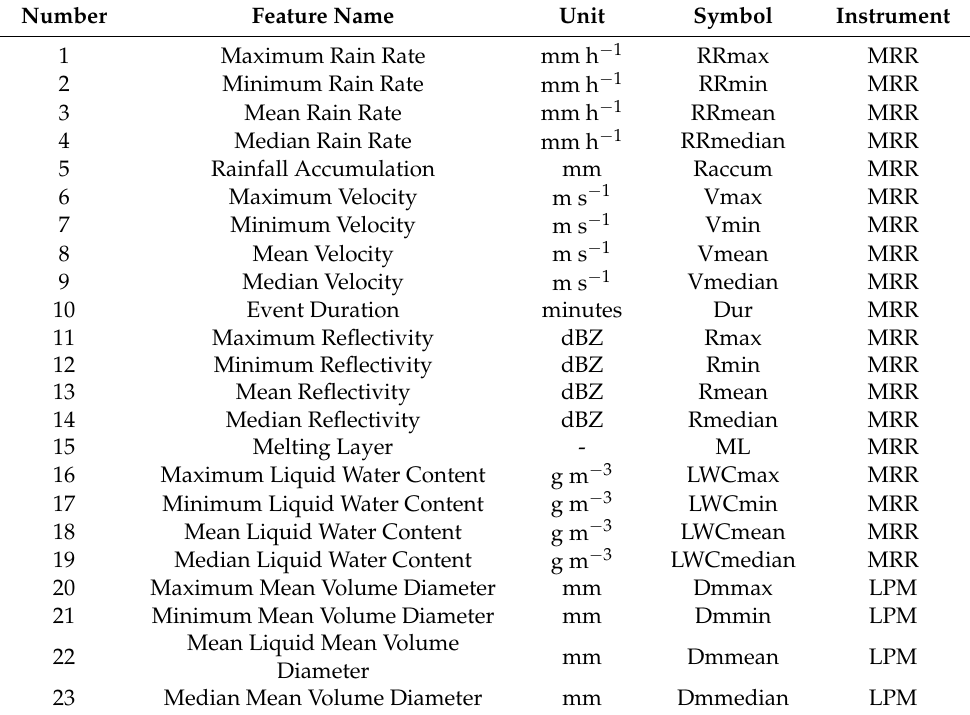
Table A1. The 23 Rainfall events features determined for each